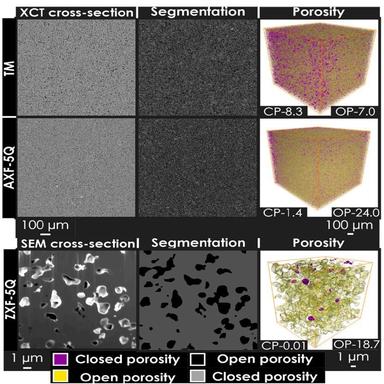
XCT data of POCO graphite grades. Reconstructed raw XCT slice, segmented graphite, CP – closed porosity and OP – open porosity. The percentages included in the illustrations provide the content of CP and OP in each grade.